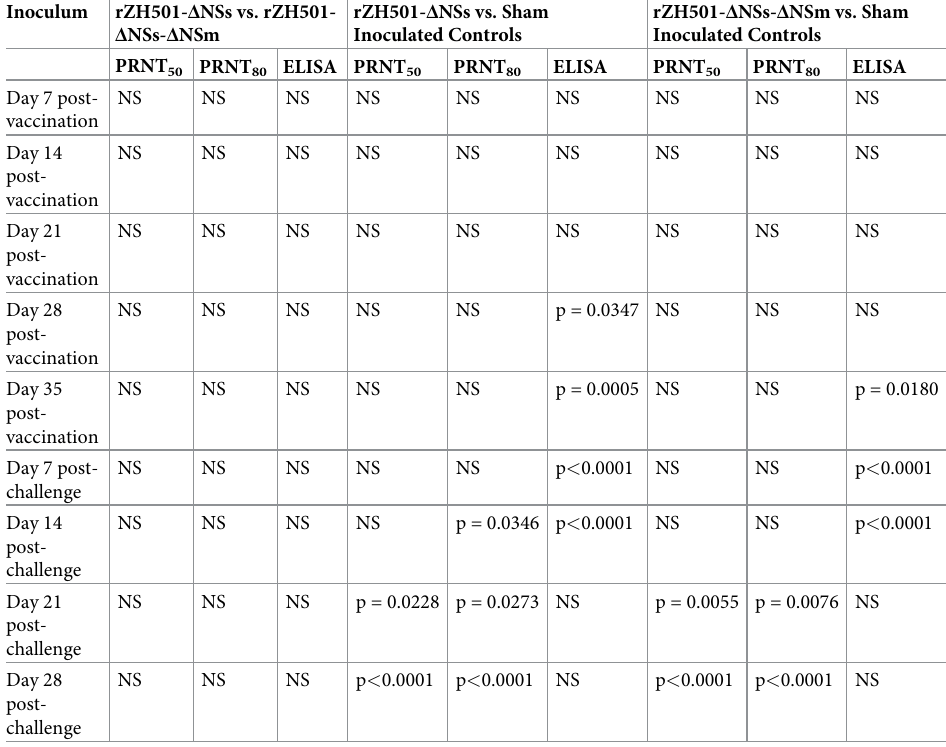
Table 2. Comparison of the neutralizing antibody response and anti-RVFV total IgG response by Tukey’s multi- ple comparisons test; NS = not